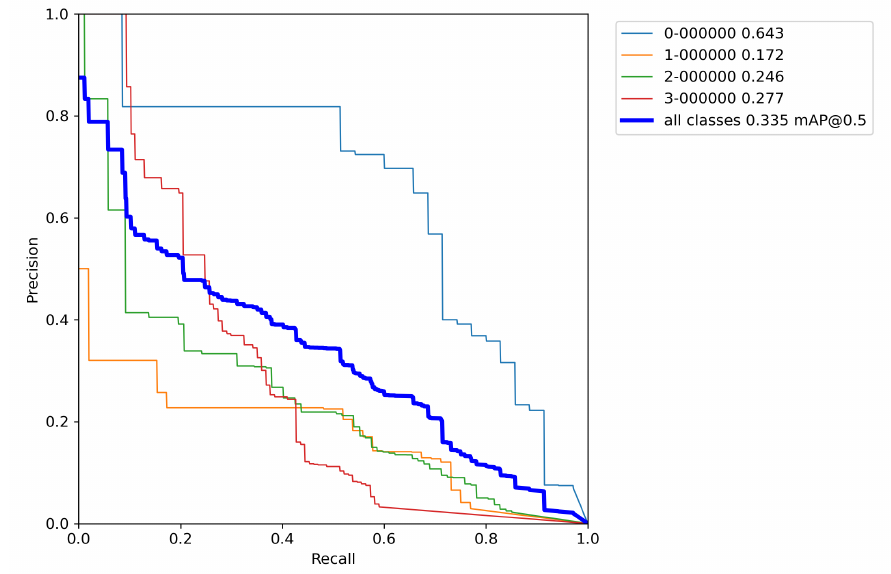
Figure A8. Model trained with classic augmentation techniques P–R curve—Experiment 3.